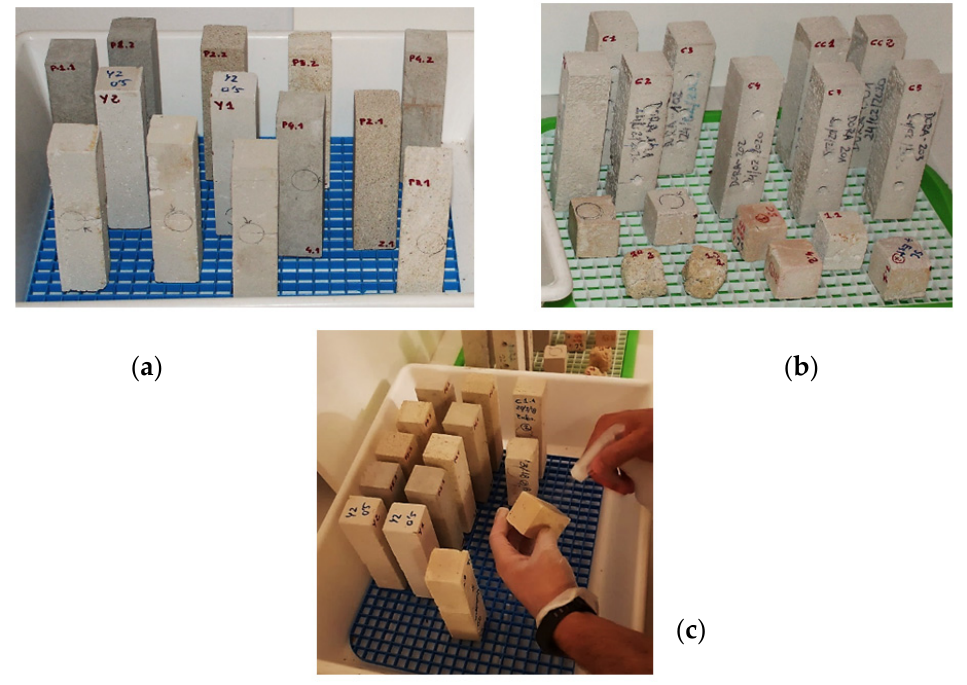
Figure 7. ( a ) Bateig stone specimens; ( b ) lime mortar specimens ( c ). Spray application of nutritional solution ( c ).